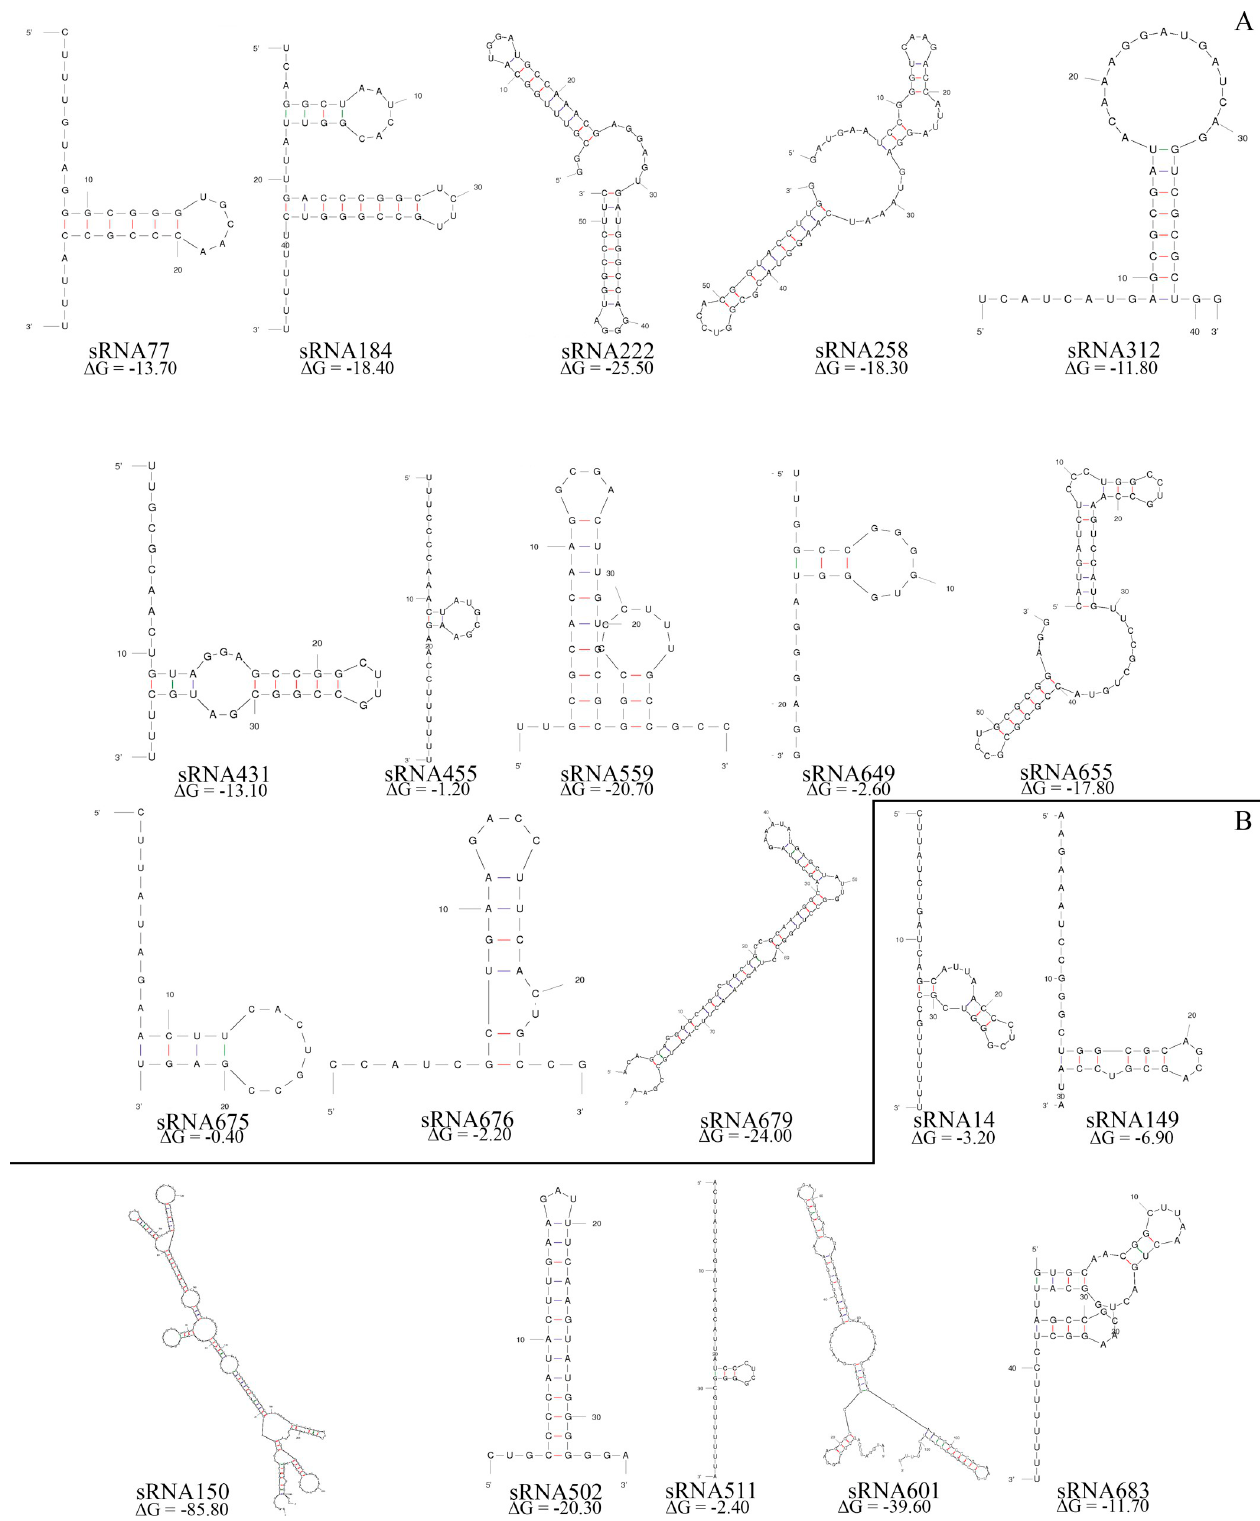
Fig 2. Prediction of the secondary structure of the 20 sRNAs with differential expression in P . pseudoalcaligenes CECT5344. The secondary putative structures of the identified sRNAs were predicted using the Mfold software [46]. A. Small RNAs induced by the jewelry wastewater. B. Small RNAs repressed by the jewelry